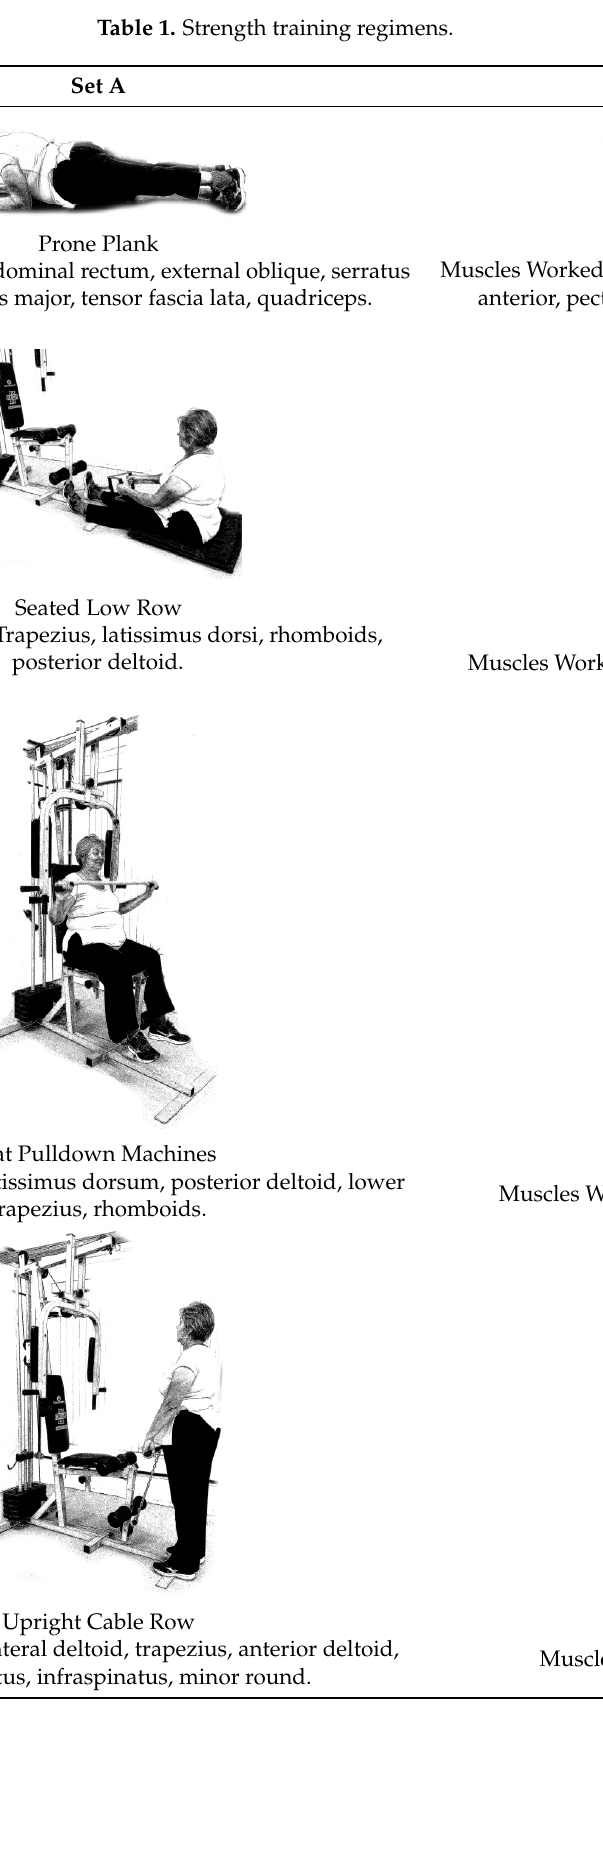
Standing Bicep Curl (Cable) Muscles Worked: Biceps, brachialis, brachioradialis, anterior deltoid, forearm. Cable Hip Abduction Muscles Worked: Gluteus maximus, gluteus minimus, tensor fascia lata. Standing Leg Curl Muscles Worked: Isquiotibiales, gluteos, sural triceps. Cable Hip Adduction Muscles Worked: Long adductor, short adductor, magnum, gracilis, pectinous.